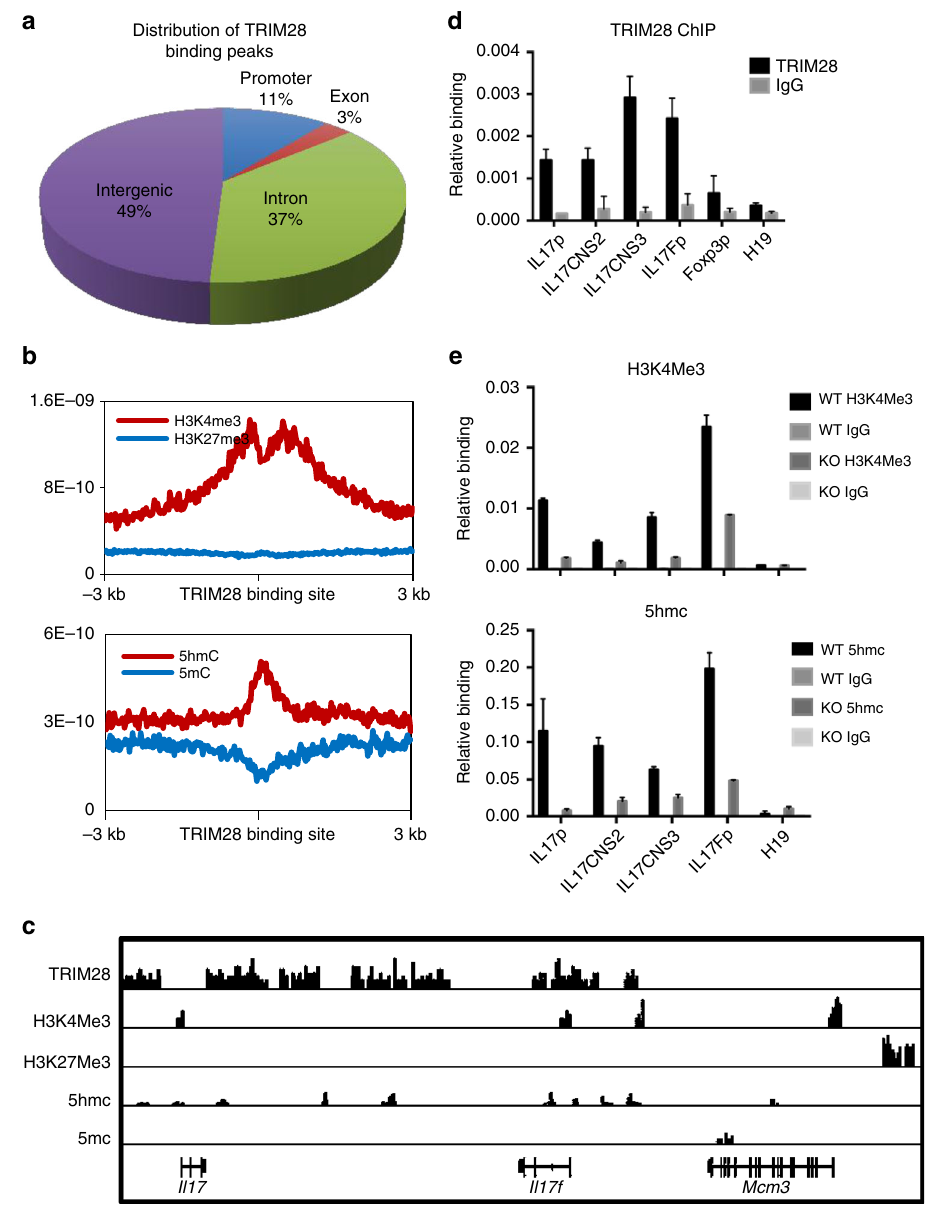
Fig. 4 TRIM28 bound to the Il17-Il17f gene locus in Th17 cells. a − d Naive CD4 + T cells were cultured under Th17 condition (TGF- β plus IL-6) for 1 day